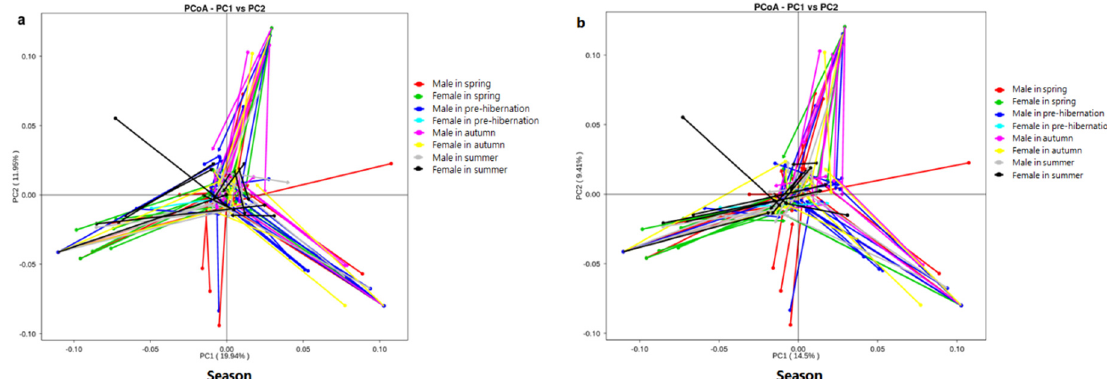
Figure 6. The relationship between food types and gut microbes. ( a ) Procrustes analysis combining weighted UniFrac PCoA; ( b ) Procrustes analysis combining unweighted UniFrac PCoA. The abscissa is the first principal component and the percentage represents the contribution of the first principal component to the sample difference; The ordinate is the second principal component and the percentage represents the contribution of the second principal component to the sample difference; Each point in the figure represents an individual and samples in the same group are represented by the same color.